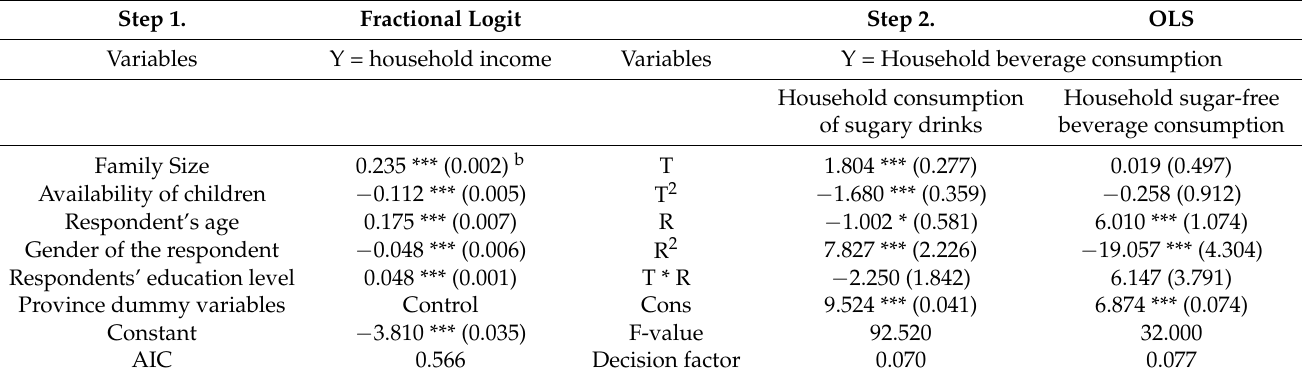
Table 4. Generalized propensity score matching first and second step regression results a